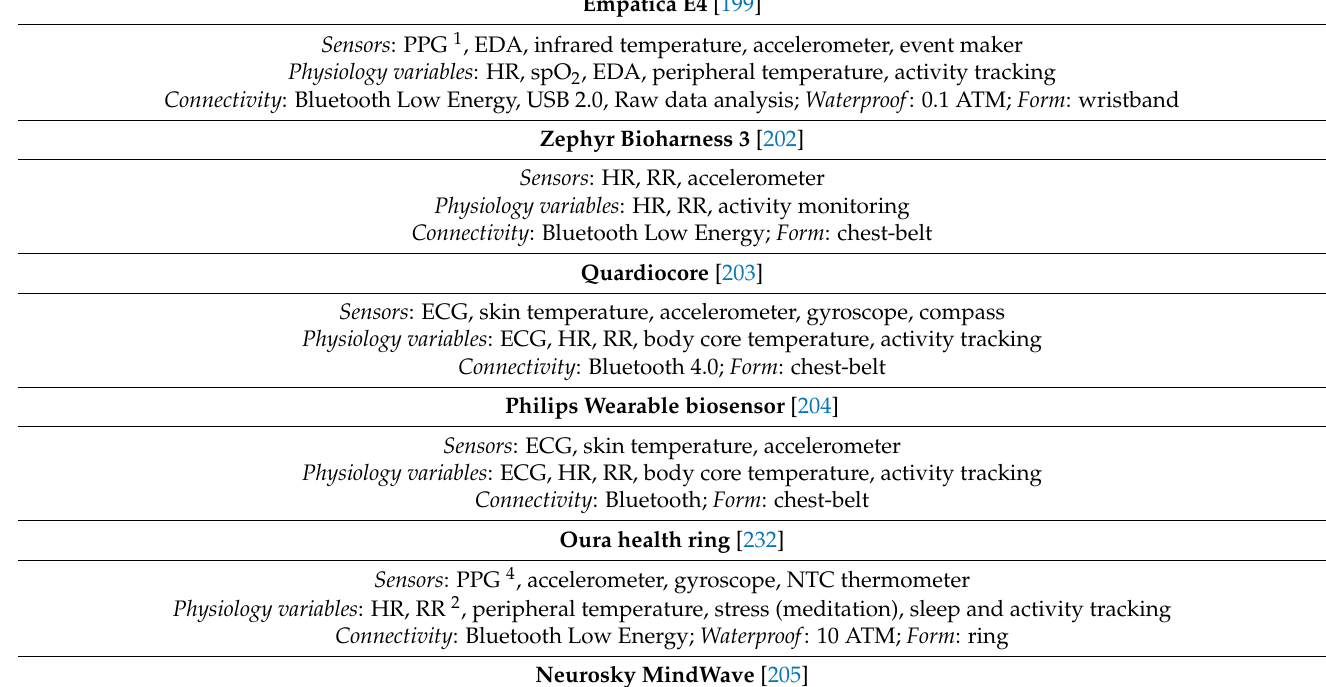
Table 1. Cont. Empatica E4